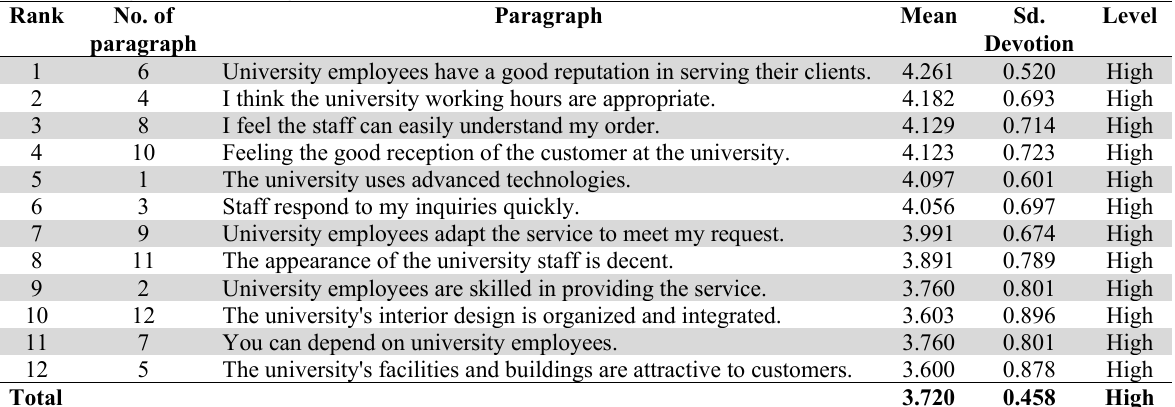
Arithmetic averages and standard deviations of customer perceptions of respondents to the level of marketing